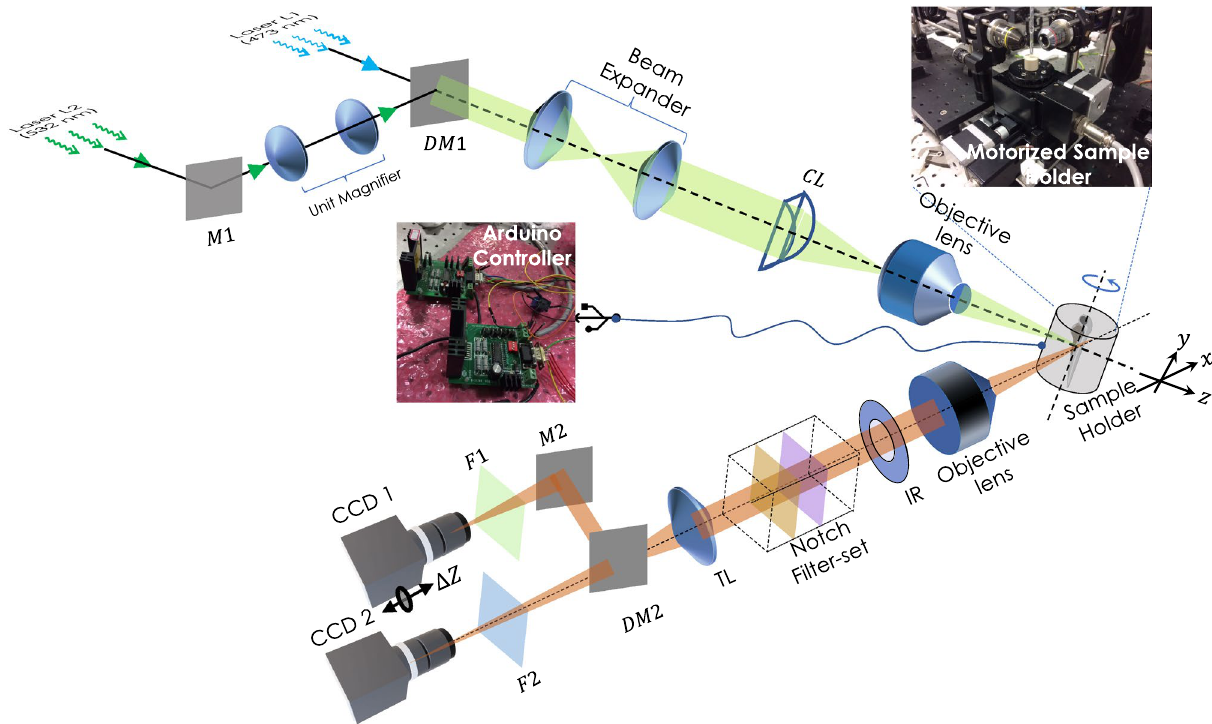
Figure 1. Schematic diagram of multicolor Lightsheet based OVSS fluorescence system. Two distinct wavelength of light sources ( (cid:31) 1 = 473 nm and (cid:31) 2 = 532 nm) are used to excite spectrally-distinct fluorophores. A unit magnifier (with lens separated by a distance > ( f 1 + f 2 ) ) is placed in one of the illumination arms to correct for the focal-shift ( (cid:31) Z ) due to chromatic aberration induced by 10 × objective lens. Beams are combined by Dichroic mirror (DM1), expanded and passed through cylindrical lens (CL, f = 150 mm) to generate the light sheet. Additionally, we placed an objective lens (Olympus, 10 × , 0.3 NA) at the focus of cylindrical lens to generate diffraction-limited multicolor lightsheet (MLS). The specimen (encaged in a capillary tube) placed on the automated rotating-stage is illuminated by MLS. To observe the fluorescence, an orthogonal